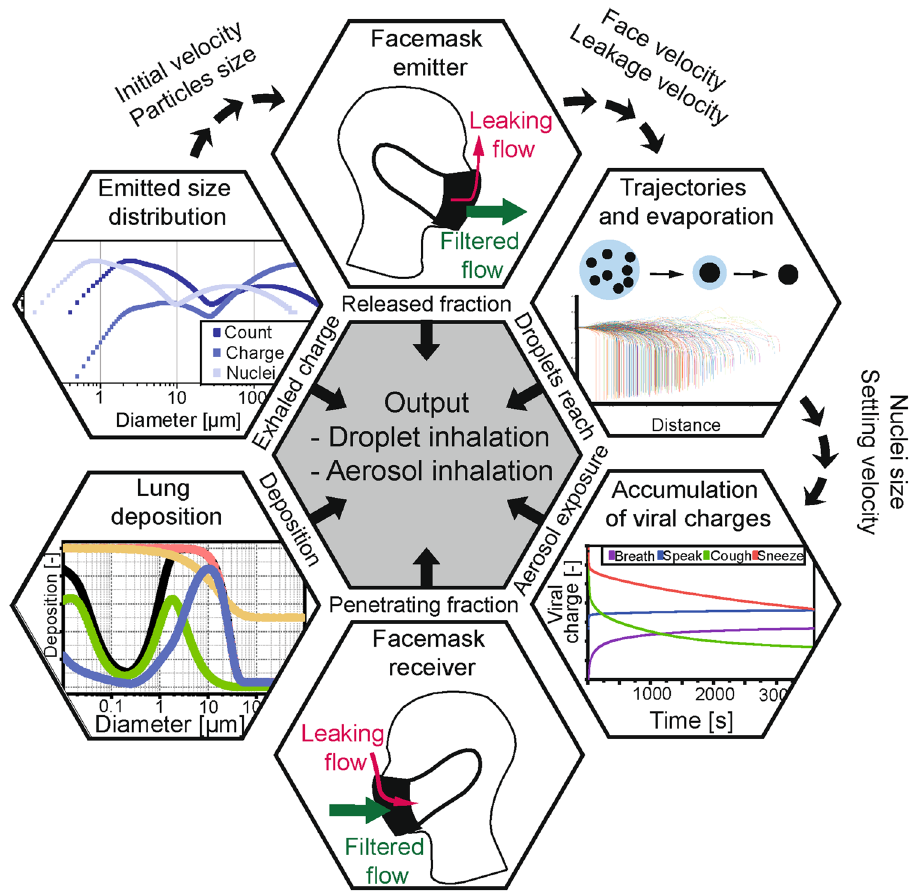
Figure 1. Structure of the model calculating the exposure level. The outputs from the single modules were combined to calculate the exposure levels due to droplets (near-field) and aerosol (far-field) exposures. The scenarios included different types of facemasks worn by the emitter (used as source control) and/or the receiver (used as respiratory protection) with various levels of leakage. The filtration efficiency curves of the facemasks were based on measurement data available in the literature and fitted with equations describing the filtration processes. The emission scenarios included breathing, with additional particle generation by speaking, coughing, and sneezing, and the corresponding size distributions were built from data available in the literature. The fraction deposited in the lung was calculated using the NCRP deposition